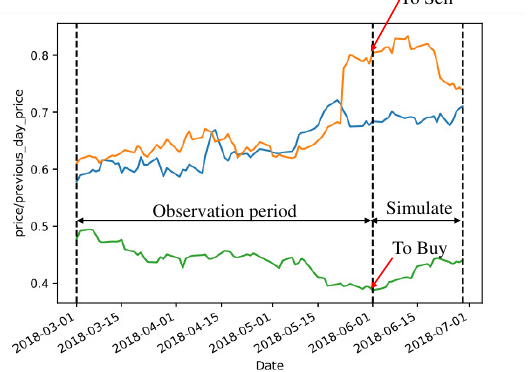
Figure 9. Visual explanation of buying and selling.